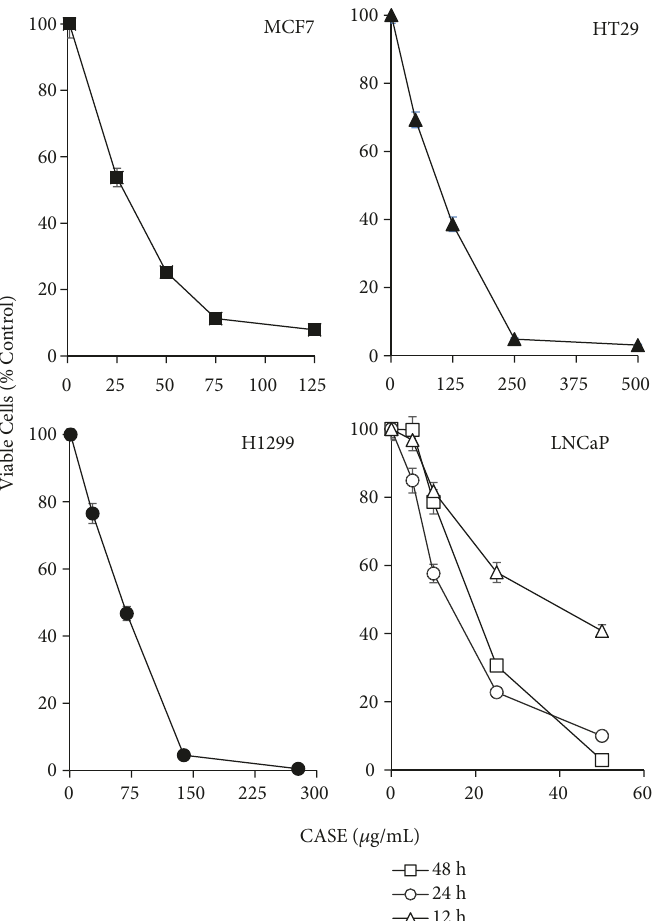
Figure 2: Effect of CASE treatment on the viability of selected human cancer cell lines in culture. MCF7, HT29, H1299, and LNCaP cells were treated for 48 h and cell viability was assessed using the MTT assay and normalized to vehicle-treated control cells. LNCaP cells were also treated for 12 and 24 h to determine the time-dependence of the effects on cell viability. Data represent the mean ± SEM of three independent